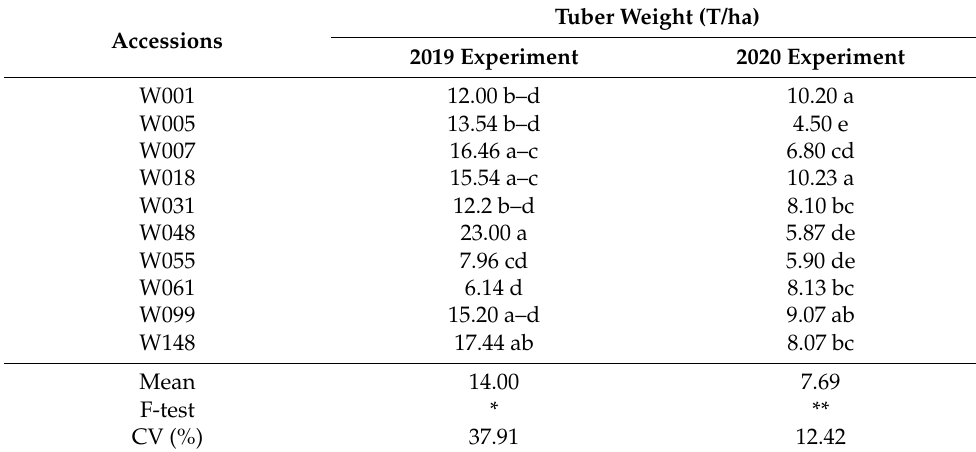
Table 3. Tuber weights of ten winged bean accessions evaluated across two years under rainy season conditions at Khon Kaen University in 2019 and 2020.